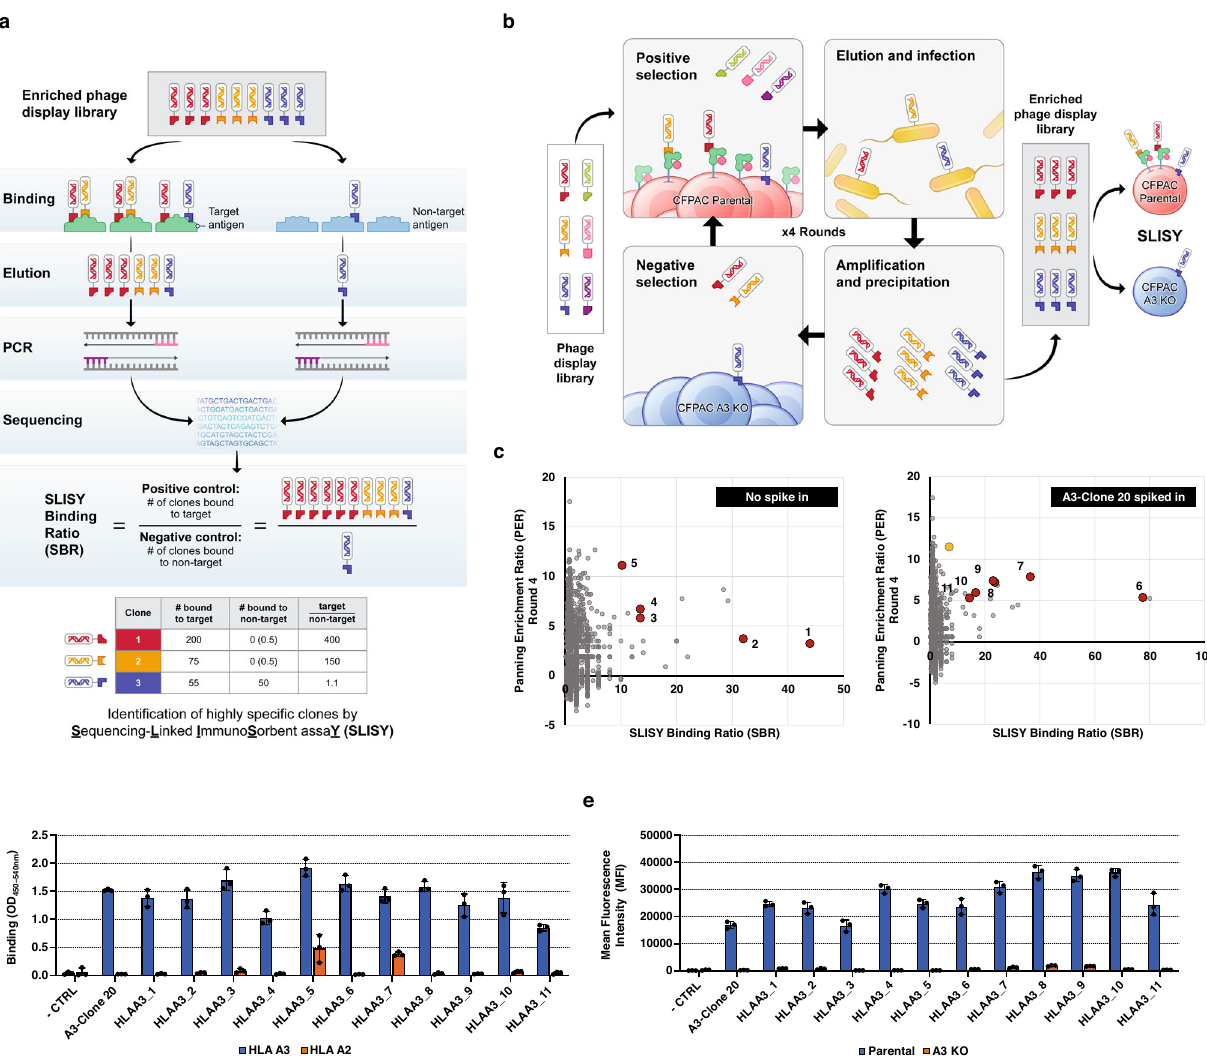
Fig. 1 | Overview of Sequencing-Linked ImmunoSorbent assaY (SLISY). a SchematicofSLISY.AsampleofscFvphagelibraryisappliedtothedesiredtarget as well as an appropriate negative control. After extensive washing, bound phage are eluted, followed by PCR ampli fi cation and sequencing of the CDR-H3 region withuniversalprimerstodetermineSLISYBindingRatios(SBR)foreachparticular phageclone.SBRiscalculatedbycomparingthenumberofphageelutedfromthe targetwell/cellswithidenticalCDR-H3sequencetothephageelutedfromthenon- target (negative) well/cells with the same CDR-H3 sequence. CDR-H3 sequences that have a molecular count of zero are given a value of 0.5. b Schematic of biopanning for HLA-A3 binders. The scFv phage display library was expanded and applied to CFPAC parental (HLA-A2 & HLA-A3 positive) cells for positive